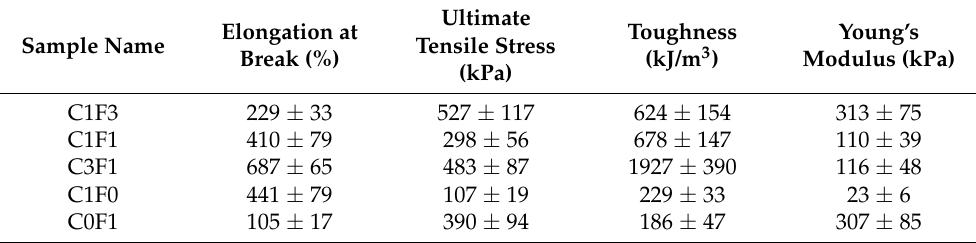
Figure 4. Mechanical properties (tensile) of the fabricated cellulose-based hydrogels. ( a ) Tensile stress–strain curves, ( b ) elongation at break, ( c ) ultimate tensile stress, ( d ) toughness, and ( e ) Young’s modulus of different hydrogels fabricated with variable composition of CNC and CNF. Table 1. Calculated mechanical properties attained by tensile tests of fabricated hydrogels.